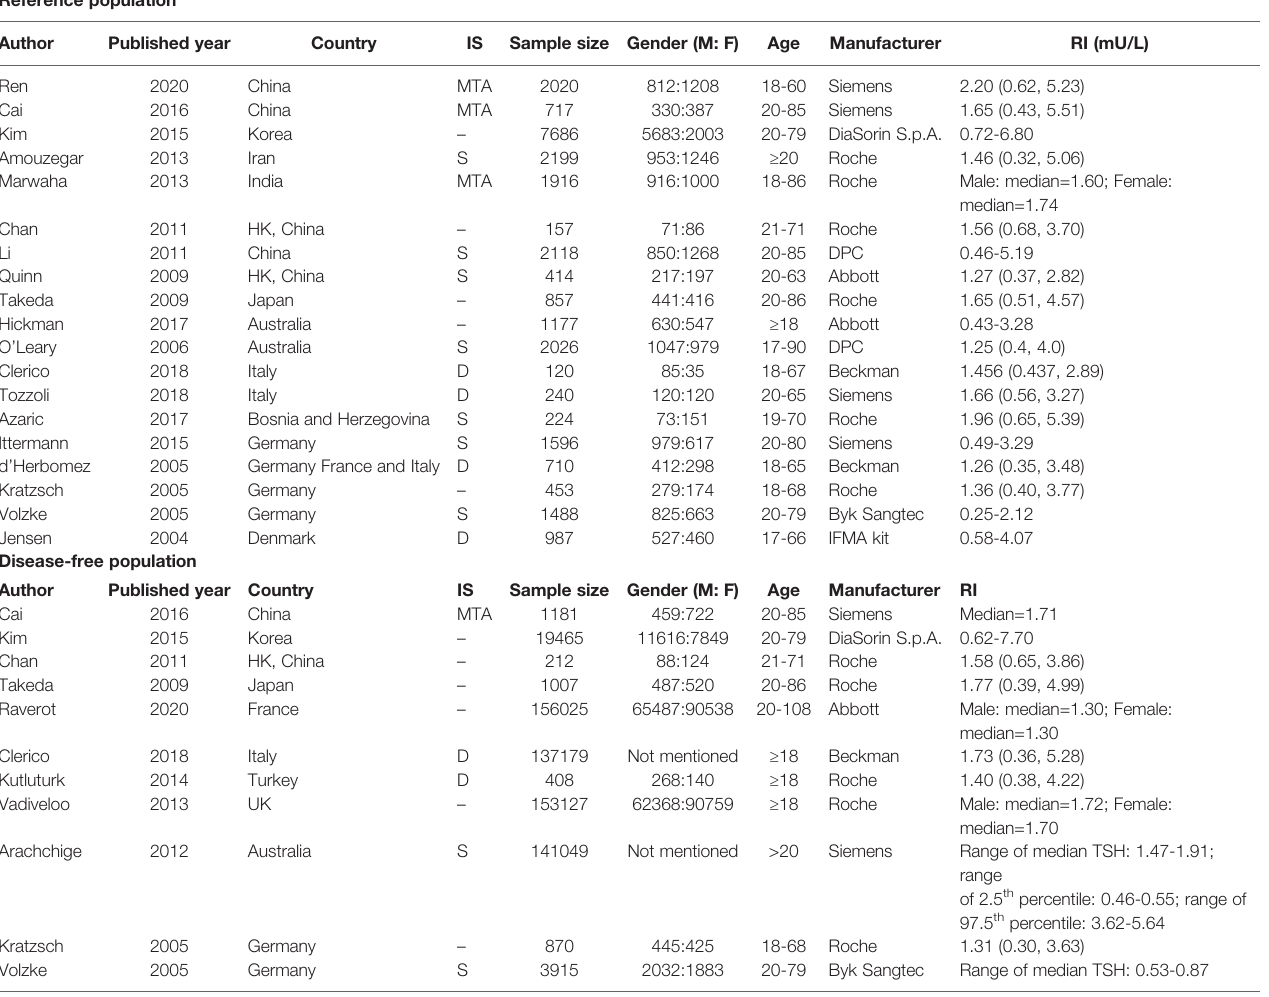
TABLE 1 | Characteristics of the selected studies.